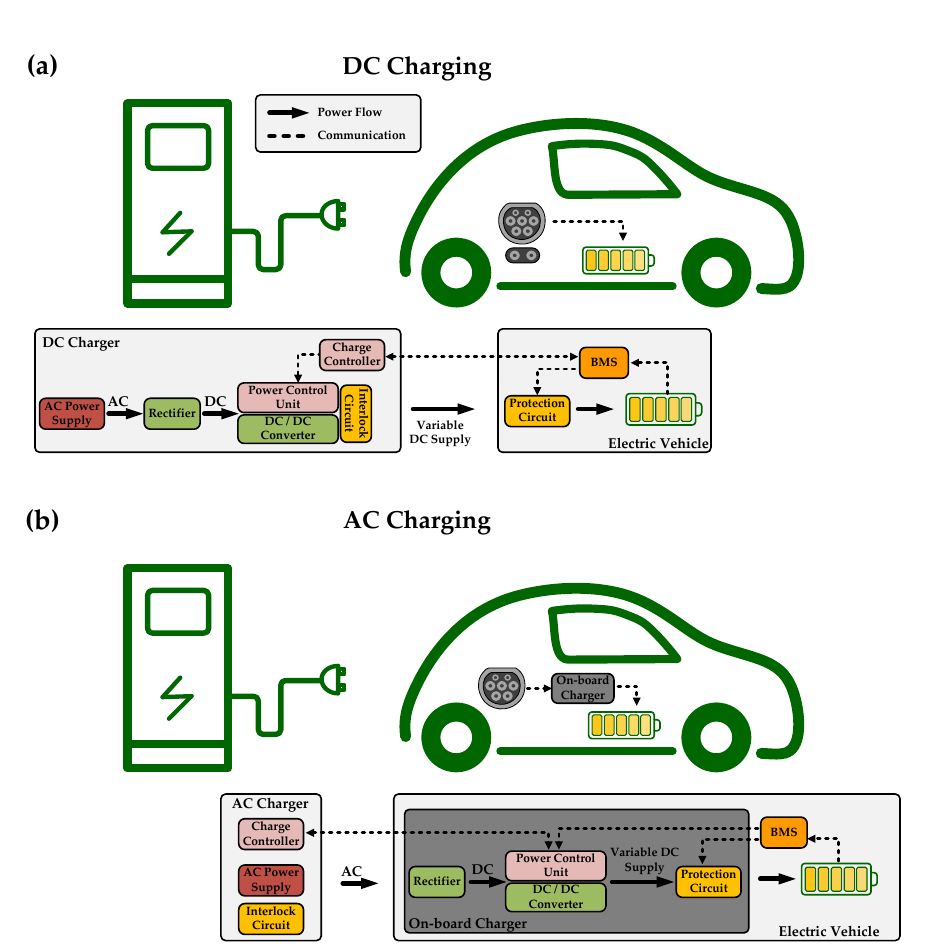
Figure 1. General schemes for ( a ) DC charging and ( b ) AC charging [25,26,27].